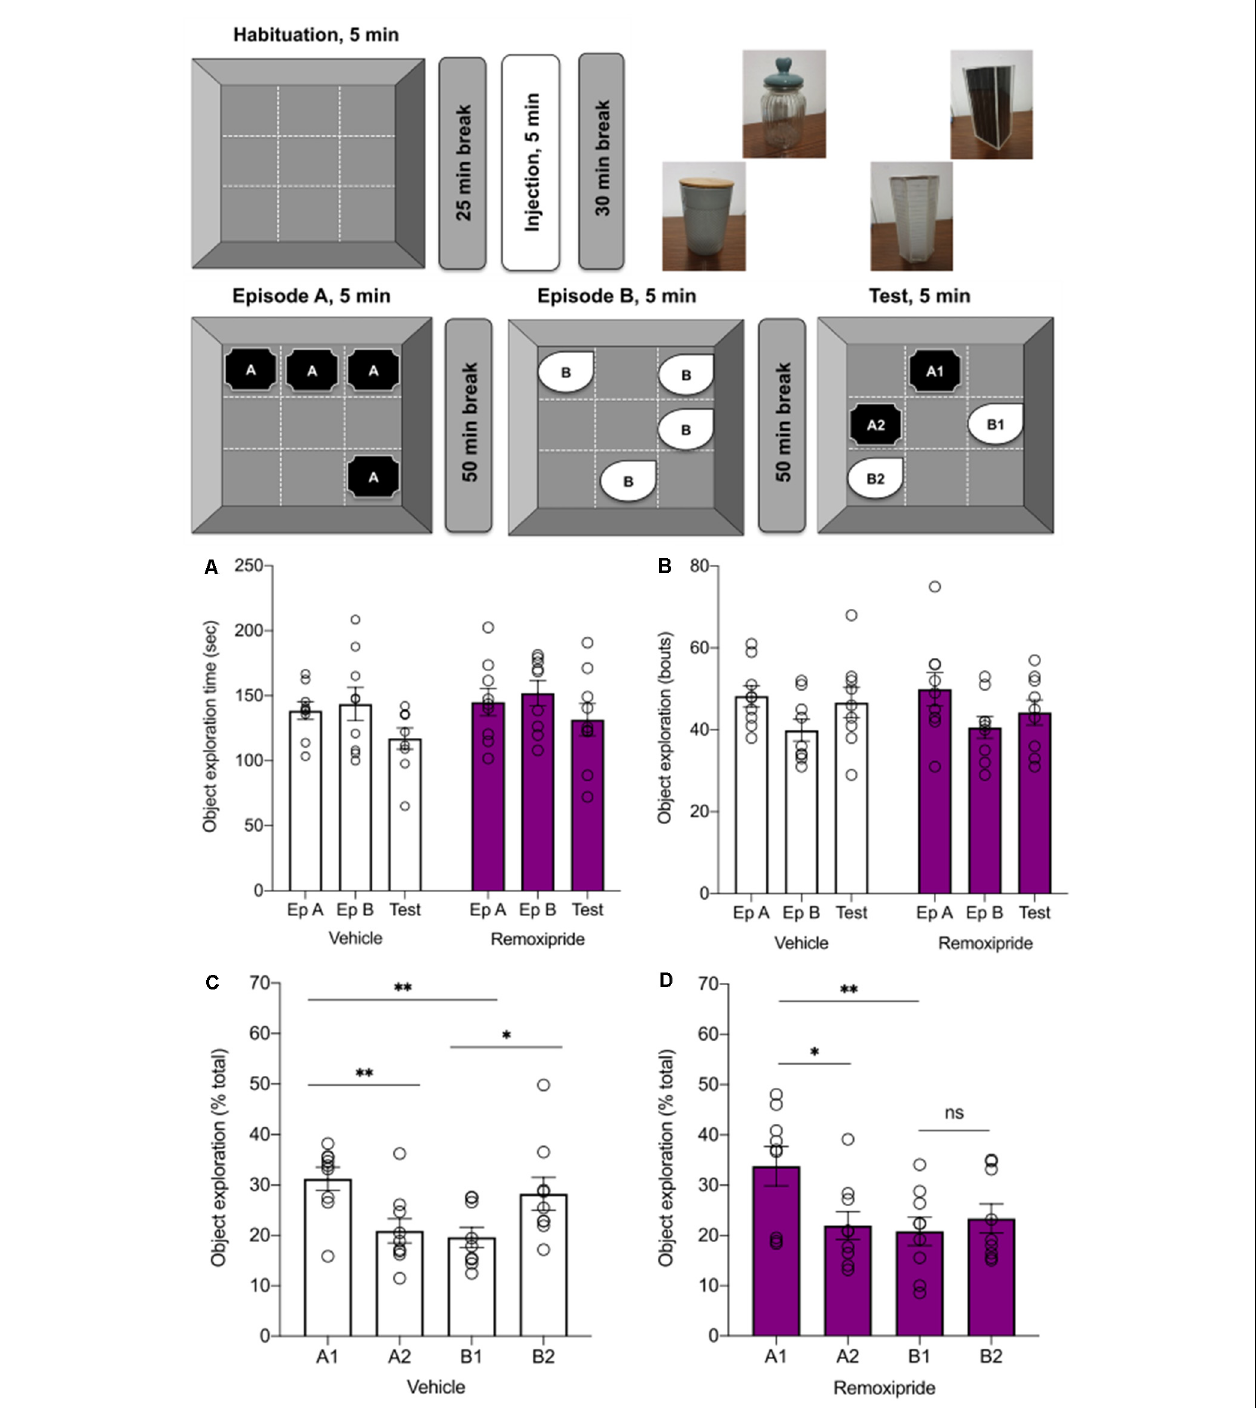
FIGURE 3 | Antagonism of dopamine D2-like receptors modulates episodic-like memory in rats. Top schema indicates the steps of the episodic-like memory task. Twenty-five minutes after a 5 min habituation phase, animals were treated with vehicle or remoxipride (50 µ g). Thirty minutes later Episode A was commenced. In Episode A (Ep A) animals encountered a novel set of objects (“A” objects) in a square arena that was segregated into nine virtual quadrants. Fifty minutes later, during Episode B (Ep B) animals encountered a new set of objects (“B” objects) whereby two objects were placed in entirely new quadrants and two objects occupied the quadrants of two (previously seen) “A” objects. In the Test phase that occurred 50 min after the conclusion of Ep B, one of the “A” objects and one of the “B” objects remained in their previous quadrants (A1, B1 “stationary”), and one “A” object (A2) and one “B” object (B2) were moved to previously unoccupied